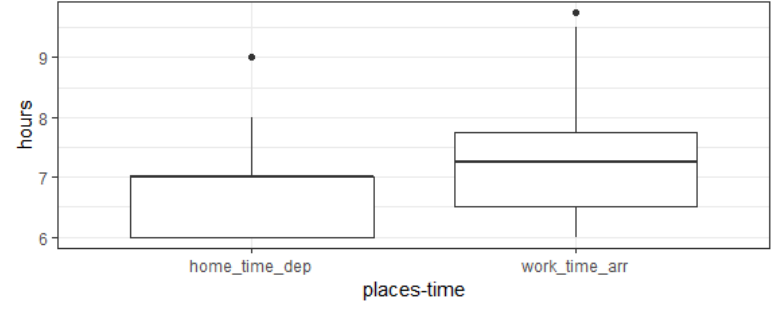
Figure 5. Distribution of home time departure and work time arrival for the ISTAT